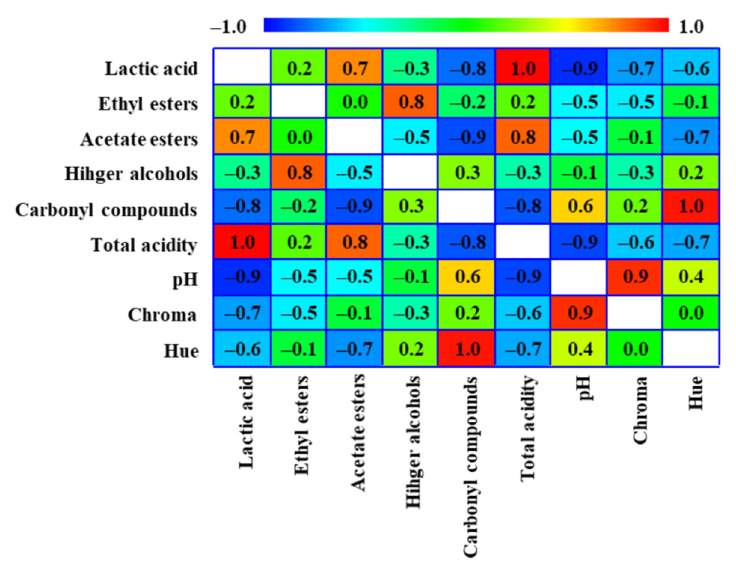
Figure 4. Pearson’s product-moment correlations taking into account the key variables for acidity, color, and aroma. Significance at p < 0.05.